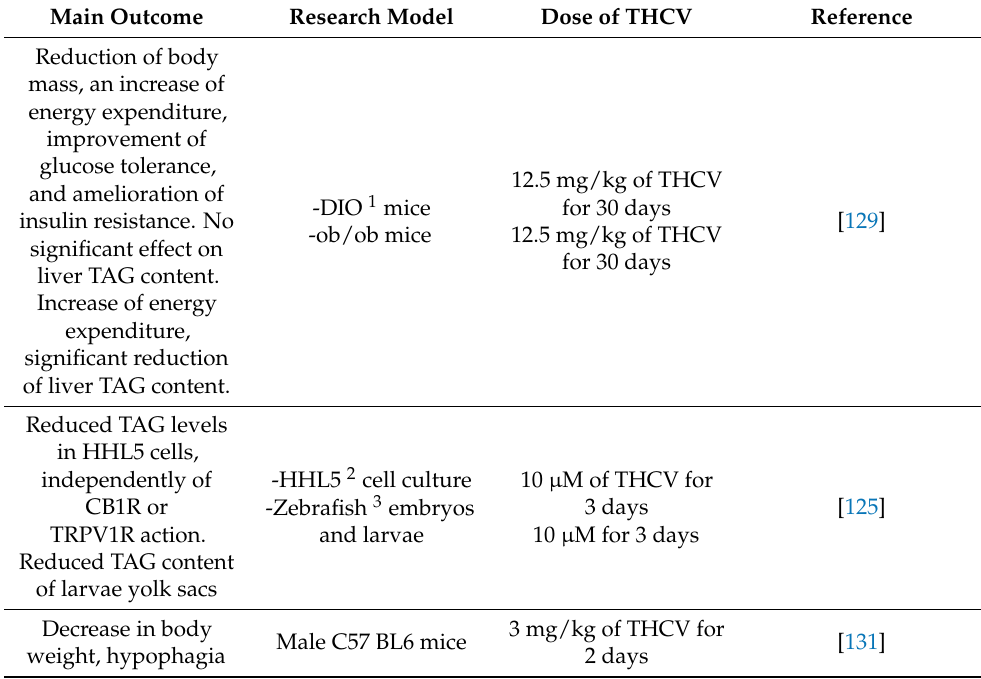
Table 5. In vitro and rat in vivo studies analyzing the effects of THCV in NAFLD and its comorbidities development.